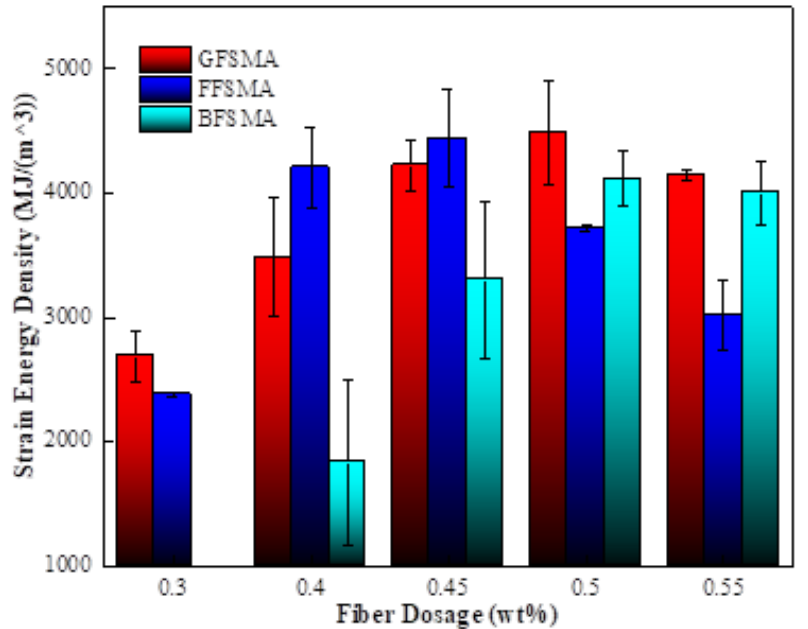
Figure 11. Strain energy density of mixtures.